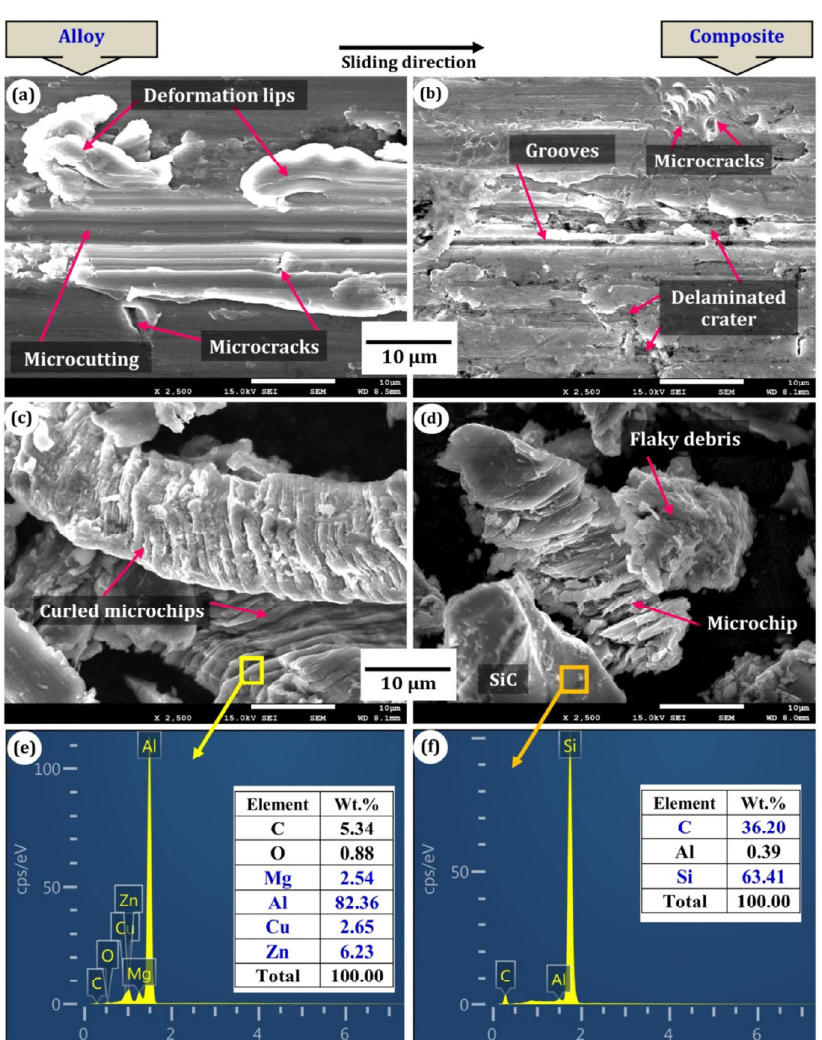
Fig. 14 FE SEM micrographs presenting abraded surfaces (a–b) and generated wear debris (c–d) of alloy (a–c) and composite (b–d) under the condition of solution No. 1 in Table 7 obtained considering multi-response optimization technique. (e) and (f) present EDX profiles along with results of semi-quantitative elemental analyses corresponding to the marked areas in (c) and (d), respectively. Abrasion conditions were 80 N load, 23  m SiC abrasive size, 35 m sliding distance, and 1.0 m·s − 1 sliding